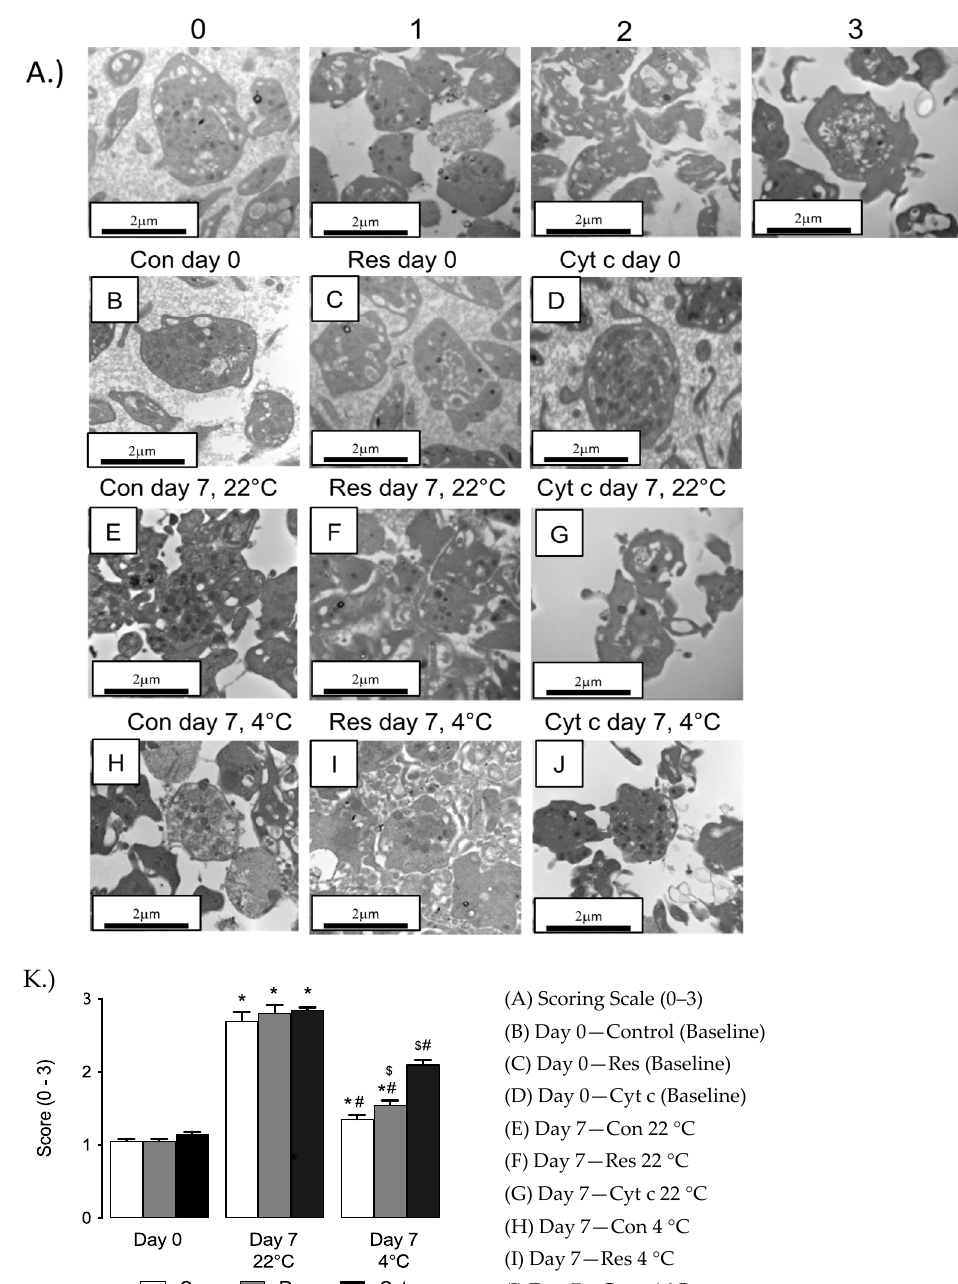
Figure 4. ( A ) Representative images from transmission electron microscopy (TEM; 25,000 × magnifica- tion) of platelets under different storage conditions used to develop a scoring scale for morphological platelet evaluation. Scale bar = 600 nm. Representative image of platelets stored at ( B ) Untreated control (Con) day 0; ( C ) Resveratrol (Res) day 0; ( D ) Cyt c day 0; ( E ) Con day 7, 22 ◦ C; ( F ) Res day 7, 22 ◦ C; ( G ) Cyt c day 7, 22 ◦ C; ( H ) Con day 7, 4 ◦ C; ( I ) Res day 7, 4 ◦ C; ( J ) Cyt c day 7, 4 ◦ C. ( K ) Cold storage improves platelet structural integrity compared to 22 ◦ C, effect of Res or Cyt c supplementation. Representative transmission electron micrographs were blind-scored (0–3 scale). * p < 0.05 versus treatment-matched day 0, # p < 0.05 4 ◦ C day 7 versus 22 ◦ C day 7 for same treatment group, $ p < 0.05 Res and Cyt C supplemented cells versus untreated.